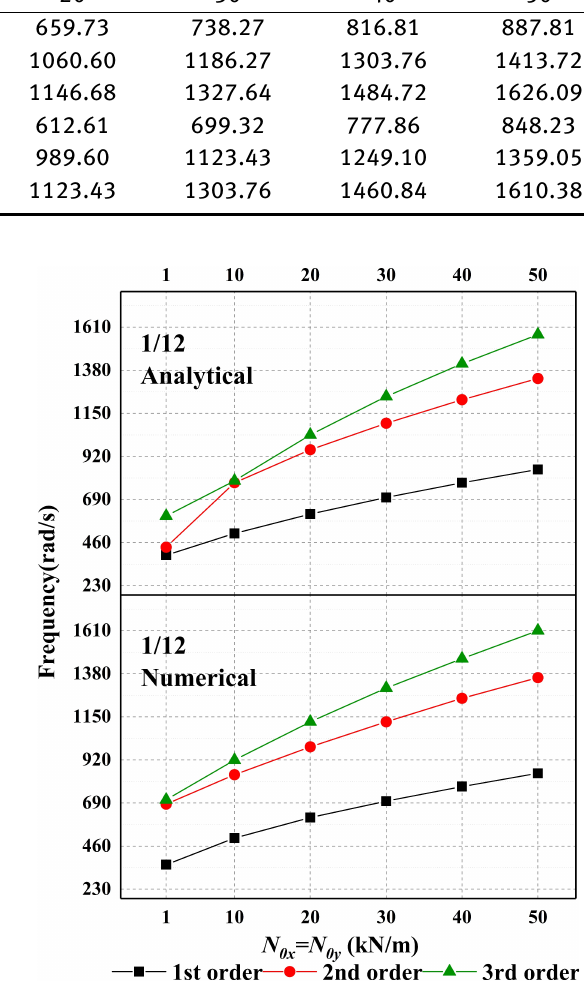
Figure 7: Comparison of natural frequencies under different pre- stressing conditions when the rise span ratio is 1/10